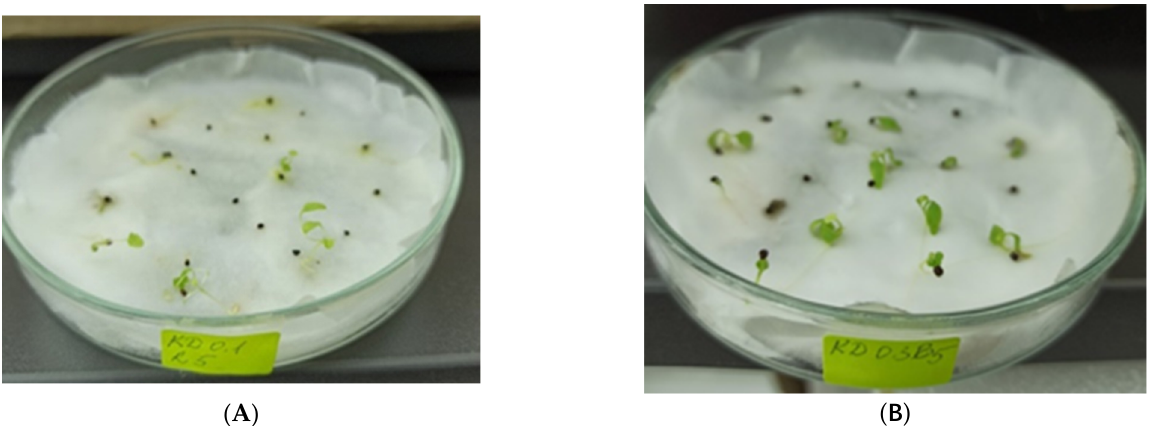
Figure 3. Seedlings of P. veris germinating in vivo under: ( A ) red light; ( B ) blue light. The results for seed germination and seedling development in each treatment vari- ant are presented in Table 2. The statistical analyses showed significant differences among treatment variants in terms of germination rate (from 0% to 95%) between the two factors tested ( p < 0.001 concerning GA 3 pretreatment and p < 0.01 concerning lights) (Table 2(A)). In 13 treatment variants, half or more of the seeds germinated. However, in all treatment variants, a number of seeds stopped their development at root stage and were eliminated. Differences between treatment variants remained significant regarding the percentage of the seedlings with cotyledons or with cotyledons and first pairs of true leaves ( p < 0.001 for GA 3 pretreatment and p < 0.05 for light), ranging between 0% and 55% of seeds developing into seedlings (Table 2(B)). Table 2. Percentages of germinated seeds and seedlings with cotyledons or first pairs of true leaves in each variant. Effect of light quality and GA 3 pretreatment on: seed germination ( A ), formation of seedlings with first pair of true leaves or with cotyledons ( B ), estimated with ANOVA two-factor without replication.